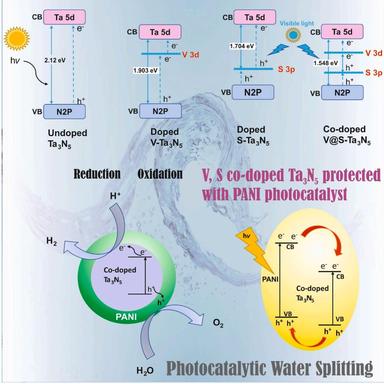
Schematic representation of the possible mechanism for the evolution of H2 via the photocatalytic process.